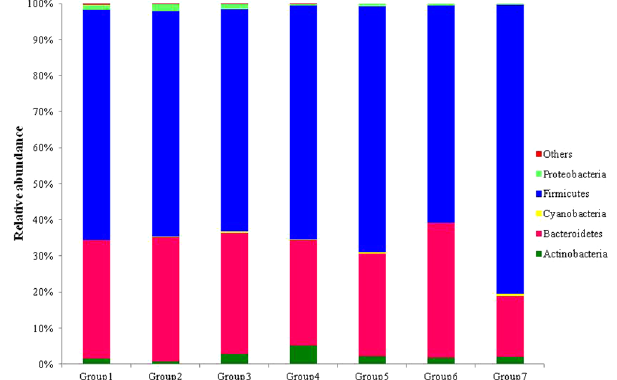
Figure 2. Phylum level composition of the caecal microbiome of chicken. A color-coded bar plot shows the average bacterial phylum distribution in different treatment groups and control group. The Group 1 to Group 6 refer to the probiotic-treated group, the Group 7 refer to the control